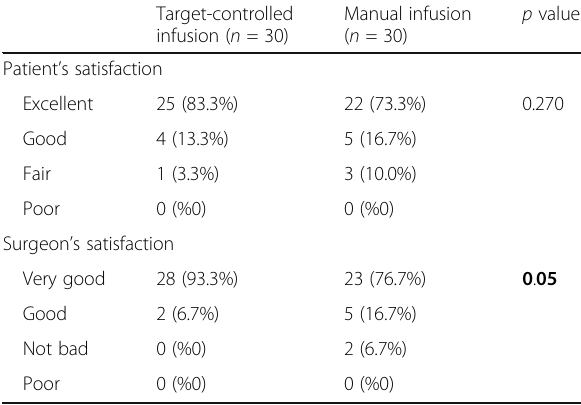
Table 4 Satisfaction of patient and surgeon during